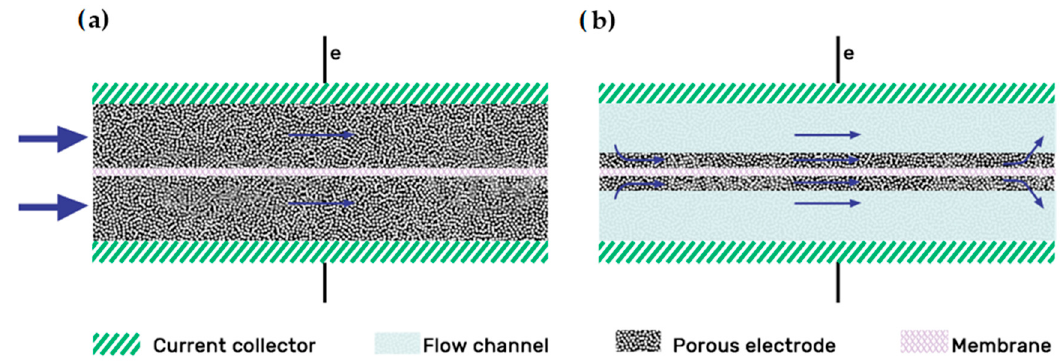
Figure 6. Electrode designs: ( a ) Flow-through; ( b ) Flow-by electrode configurations. Redrawn from [32].